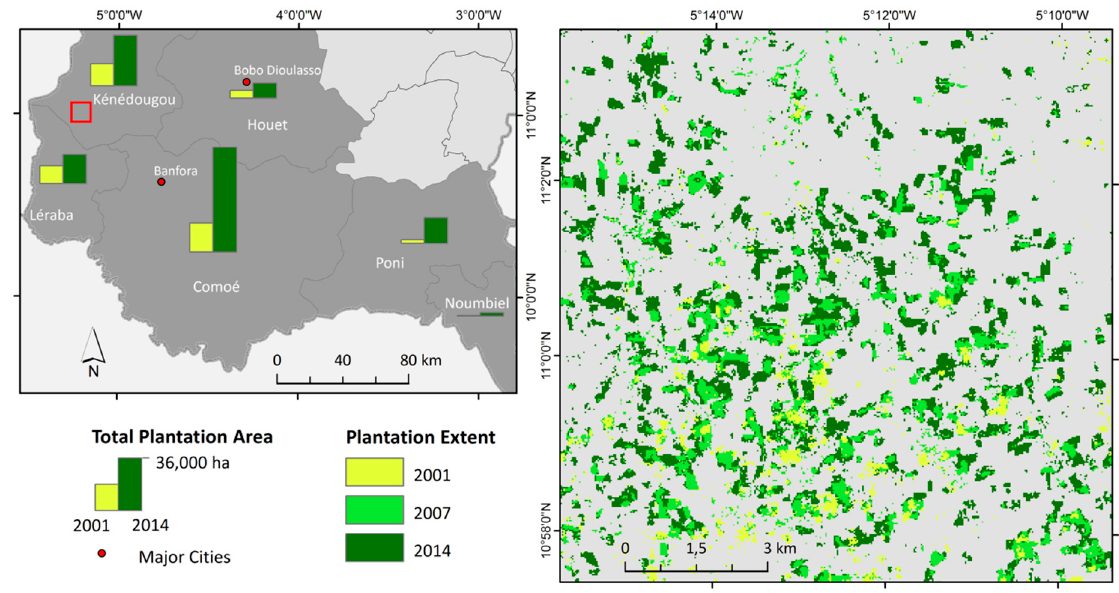
Figure 5. Major plantation provinces and their plantation coverage for 2001 and 2014 ( left ) and development of a plantation area in the province of Kénédougou between 2001 and 2014 ( right ); position marked by red rectangle in the left figure.